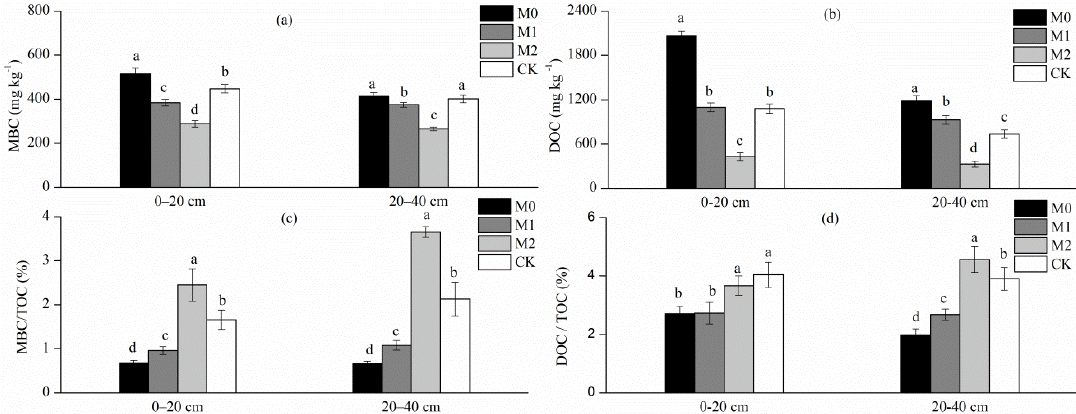
Figure 1. MBC (microbial biomass C) and DOC (dissolved organic C) contents ( a , b ), and the ratio of MBC to TOC (total organic C) and that of DOC to TOC ( c , d ) in the soil of the different studied forests.